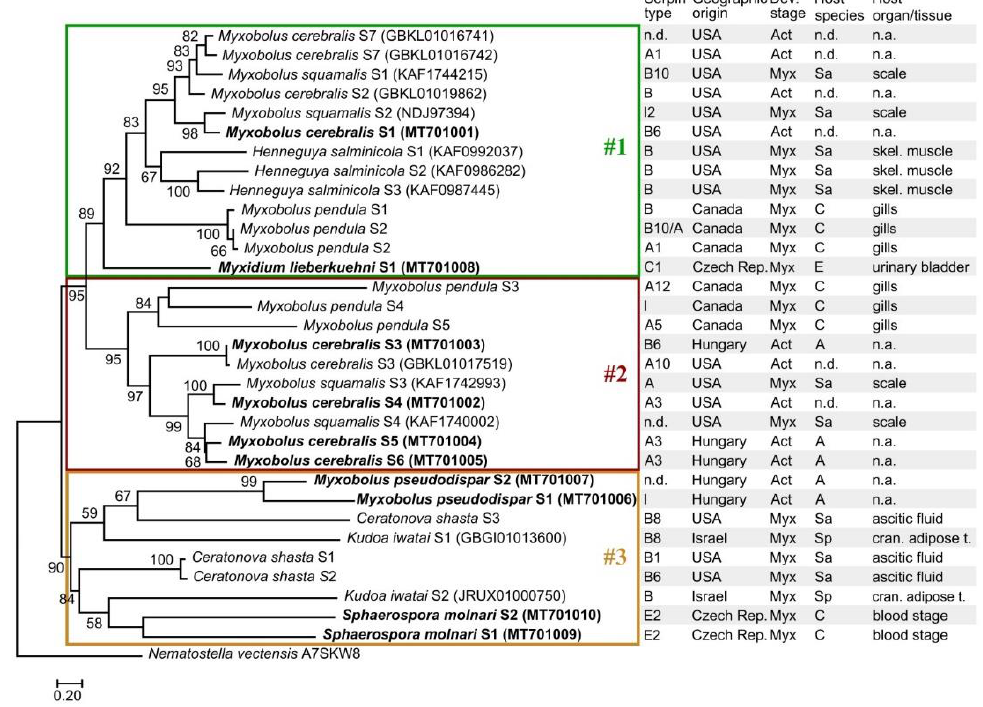
Figure 4. Maximum-likelihood tree of 32 myxozoan serpin sequences, on the basis of a 365-long amino acid sequence alignment (RAxML, LG + I + Γ 4 model, 1000 bootstrap replicates). The serpins of Thelohanellus kitauei were not included in the analysis. The free-living Cnidaria, Nematostella vectensis was used as outgroup. Bootstrap values are given as percentages. Sequences obtained with specific PCR amplification followed by DNA sequencing are highlighted bold. Subclades were indicated with boxes #1, #2, and #3. Developmental stages: Myx—myxospore; Act—actinospore; Host species: Sa—Salmonidae; C—Cyprinidae; A—Annelida; E—Esocidae; Sp—Sparidae. n.d.—no data; n.a.—not